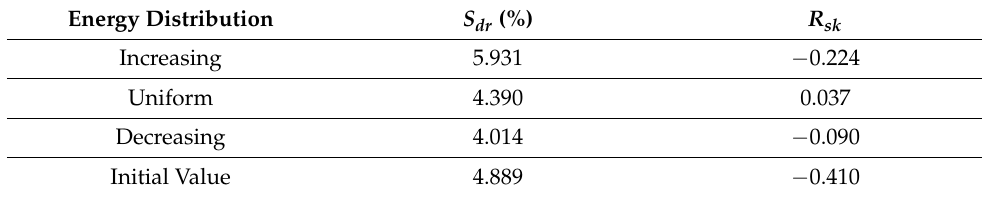
Table A11. S dr and R sk of brass.